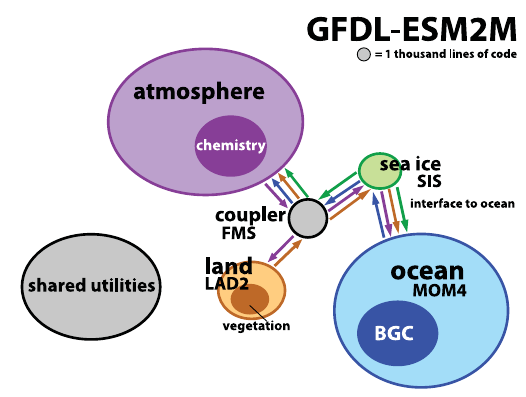
Figure 4. Architecture diagram for UVic ESCM